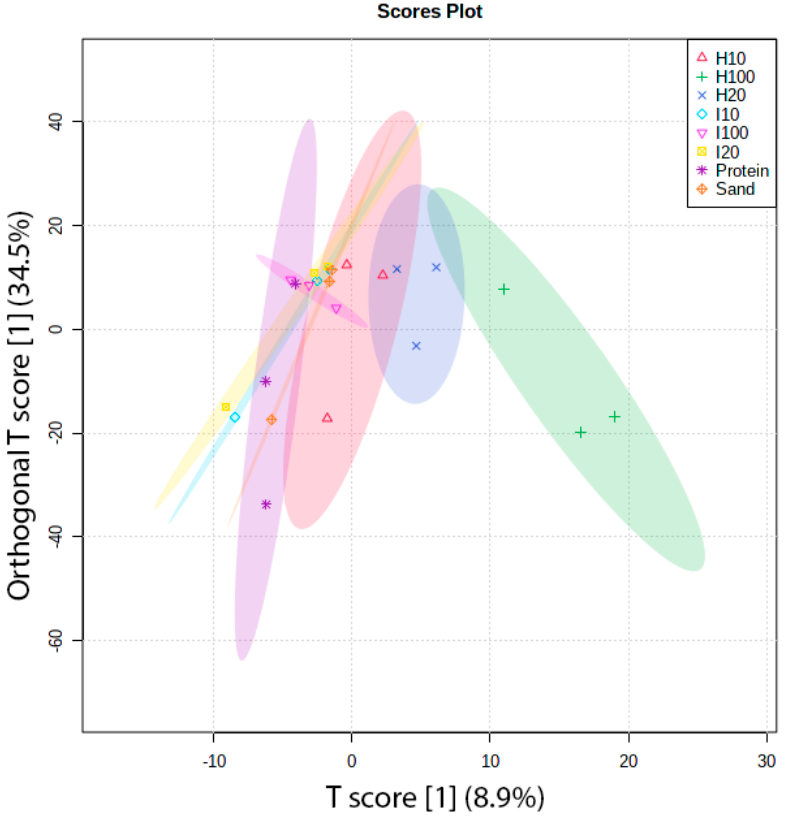
Figure 3. A score plot for all proteins present in the initial total protein extract and in supernatant portions of samples following adsorption. The score plot employs the orthogonal projections to latent structures discriminant analysis (OPLS-DA) modeling method and was developed through the MetaboAnalyst online tool [63]. Displayed regions reflect a 95% confidence interval. Prior to analysis, the data was log transformed and auto-scaled (mean centered and divided by the standard deviation of each variable). Sand = uncoated sand; Protein = initial protein sample; I10, I20, I100 = 10, 20, and 100% iron-coated sand, respectively; H10, H20, H100 = 10, 20, and 100% hydrophobic sand, respectively.